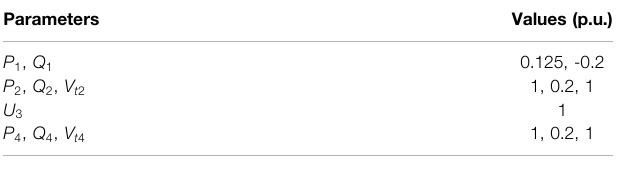
TABLE 3 | Values of parameters. Parameters Values (p.u.)